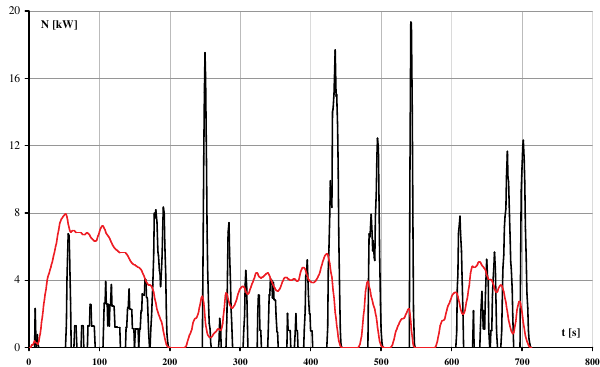
Fig. 3. The car speed variation at the lightest traffic intensity